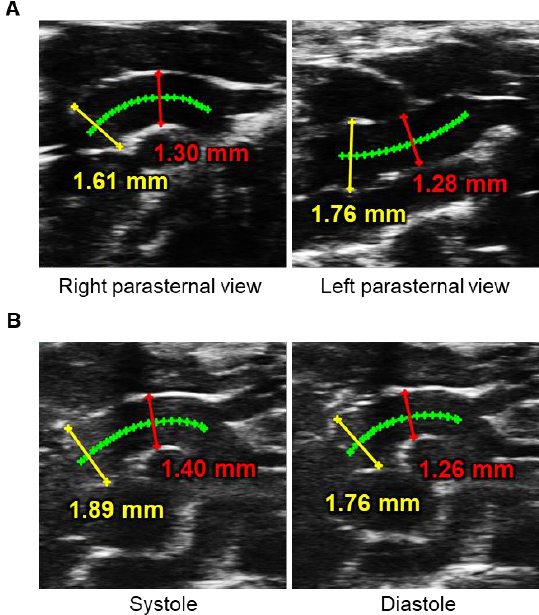
Figure 3. Impacts of ultrasound view and cardiac phase on measurements of aortic diameters in mice. ( A ) Representative ultrasound images of right and left parasternal long-axis approaches in the proximal thoracic aorta. ( B ) Luminal diameters at the aortic root (yellow) and ascending aortic (red) were measured at the mid-systole and end-diastole in the right parasternal long-axis view. Green lines placed on the center of aortic lumen were used as a reference for aortic measurements. Authors’ unpublished data. Ultrasound images were captured by Vevo 3100 with an MX550D (40 MHz).